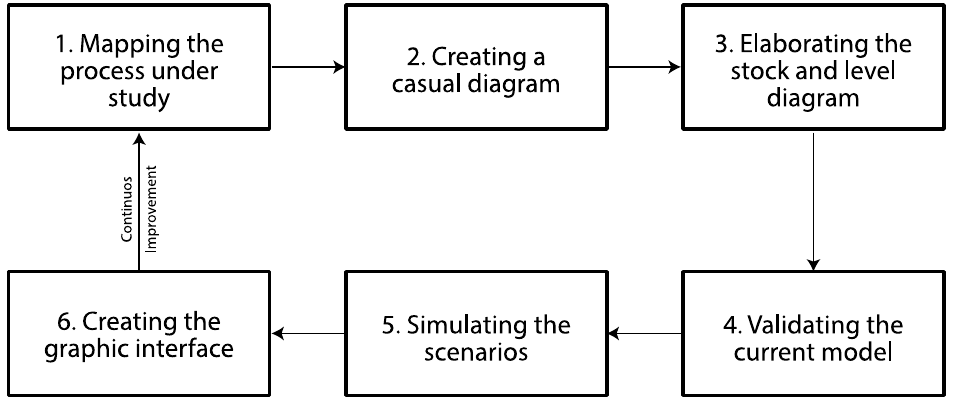
Figure 2. System dynamics methodology.